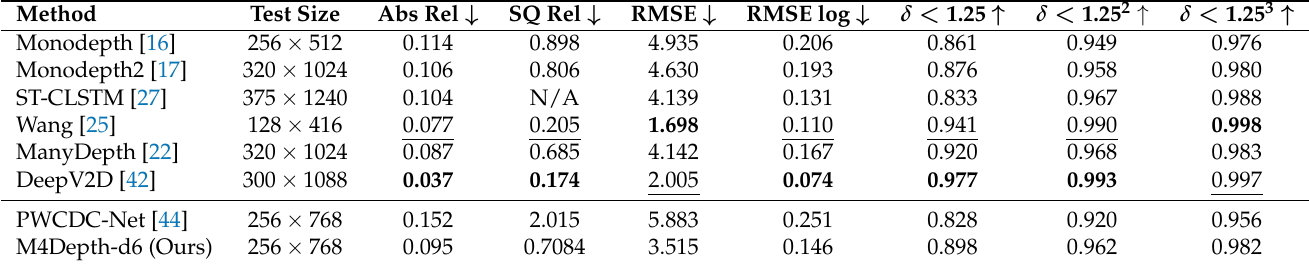
Table 3. Performance of M4Depth (best of 5 trainings) on the KITTI dataset. The scores reported for reference methods are the ones published by their respective authors. The best score for a metric is highlighted in bold and the second best is underlined. The four first metrics need to be minimized ( ↓ ) and the three last ones need to be maximized ( ↑